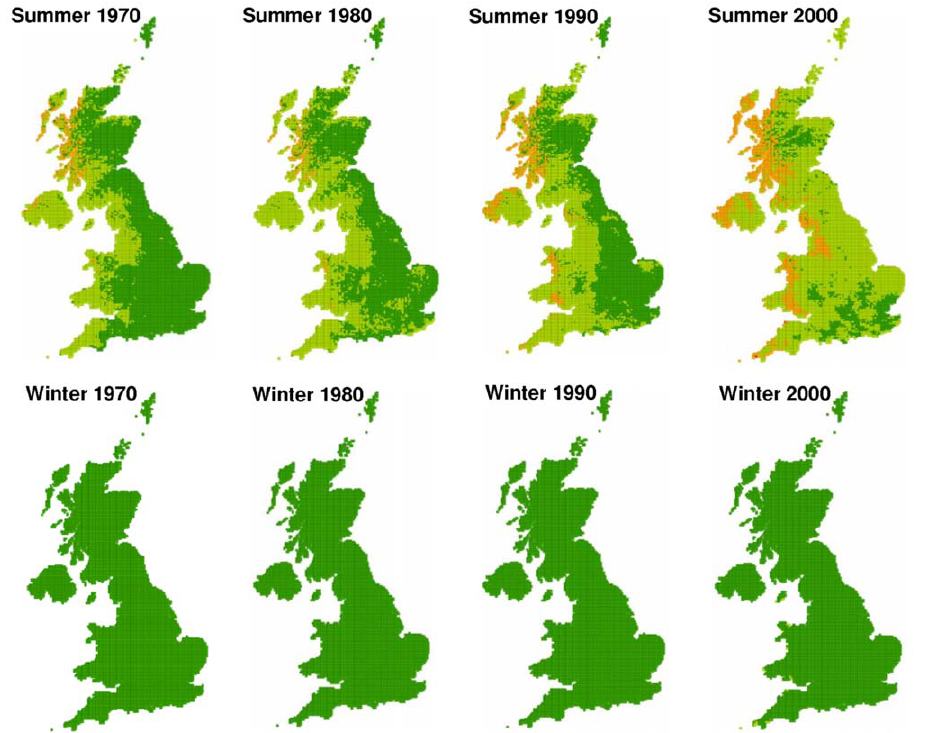
Figure 3. Past change in fasciolosis risk. Decade averages of summer and winter F.hepatica risk across the UK at a resolution of 5 km squares, 1970–2006. Risk categories are based on those used by Ollerenshaw & Rowlands [22]: Little or no disease: Mt , 300 (dark green), occasional losses: 300 , Mt =400 (light green), disease prevalent: 400 , Mt =474 (orange), serious epidemic: Mt . 474 (red).